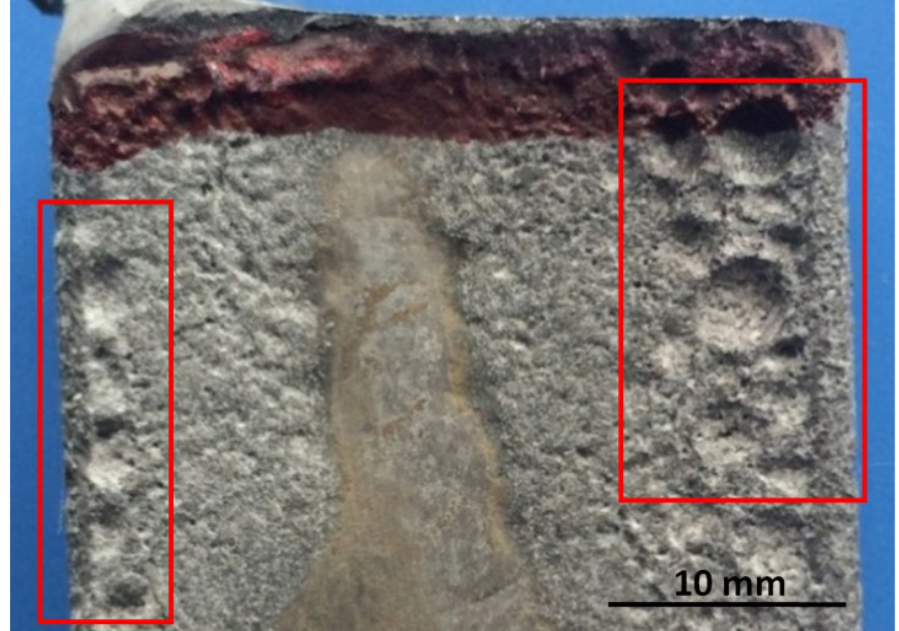
Figure 1. The surface morphology of DD6 casting by Y 2 O 3